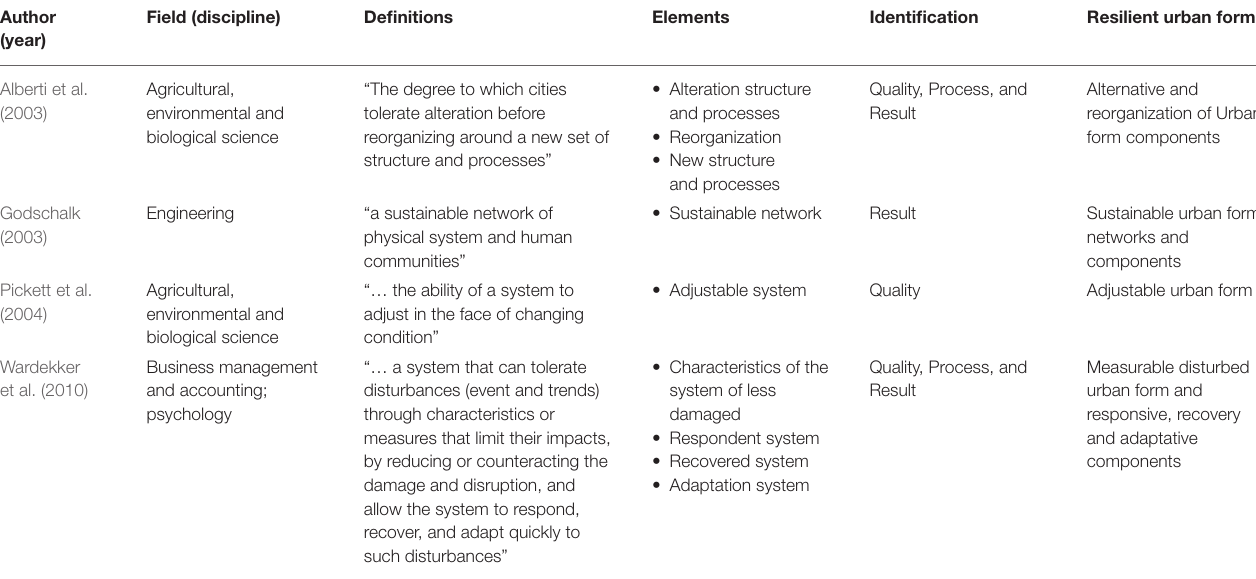
TABLE 2 | A summary of the literature on urban resilience, identified based on relevance to this